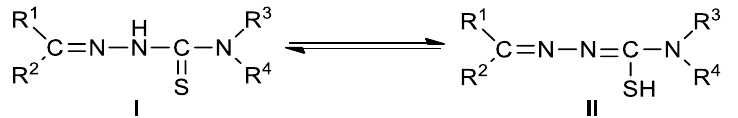
Scheme 1. Tautomerism of thiosemicarbazones.